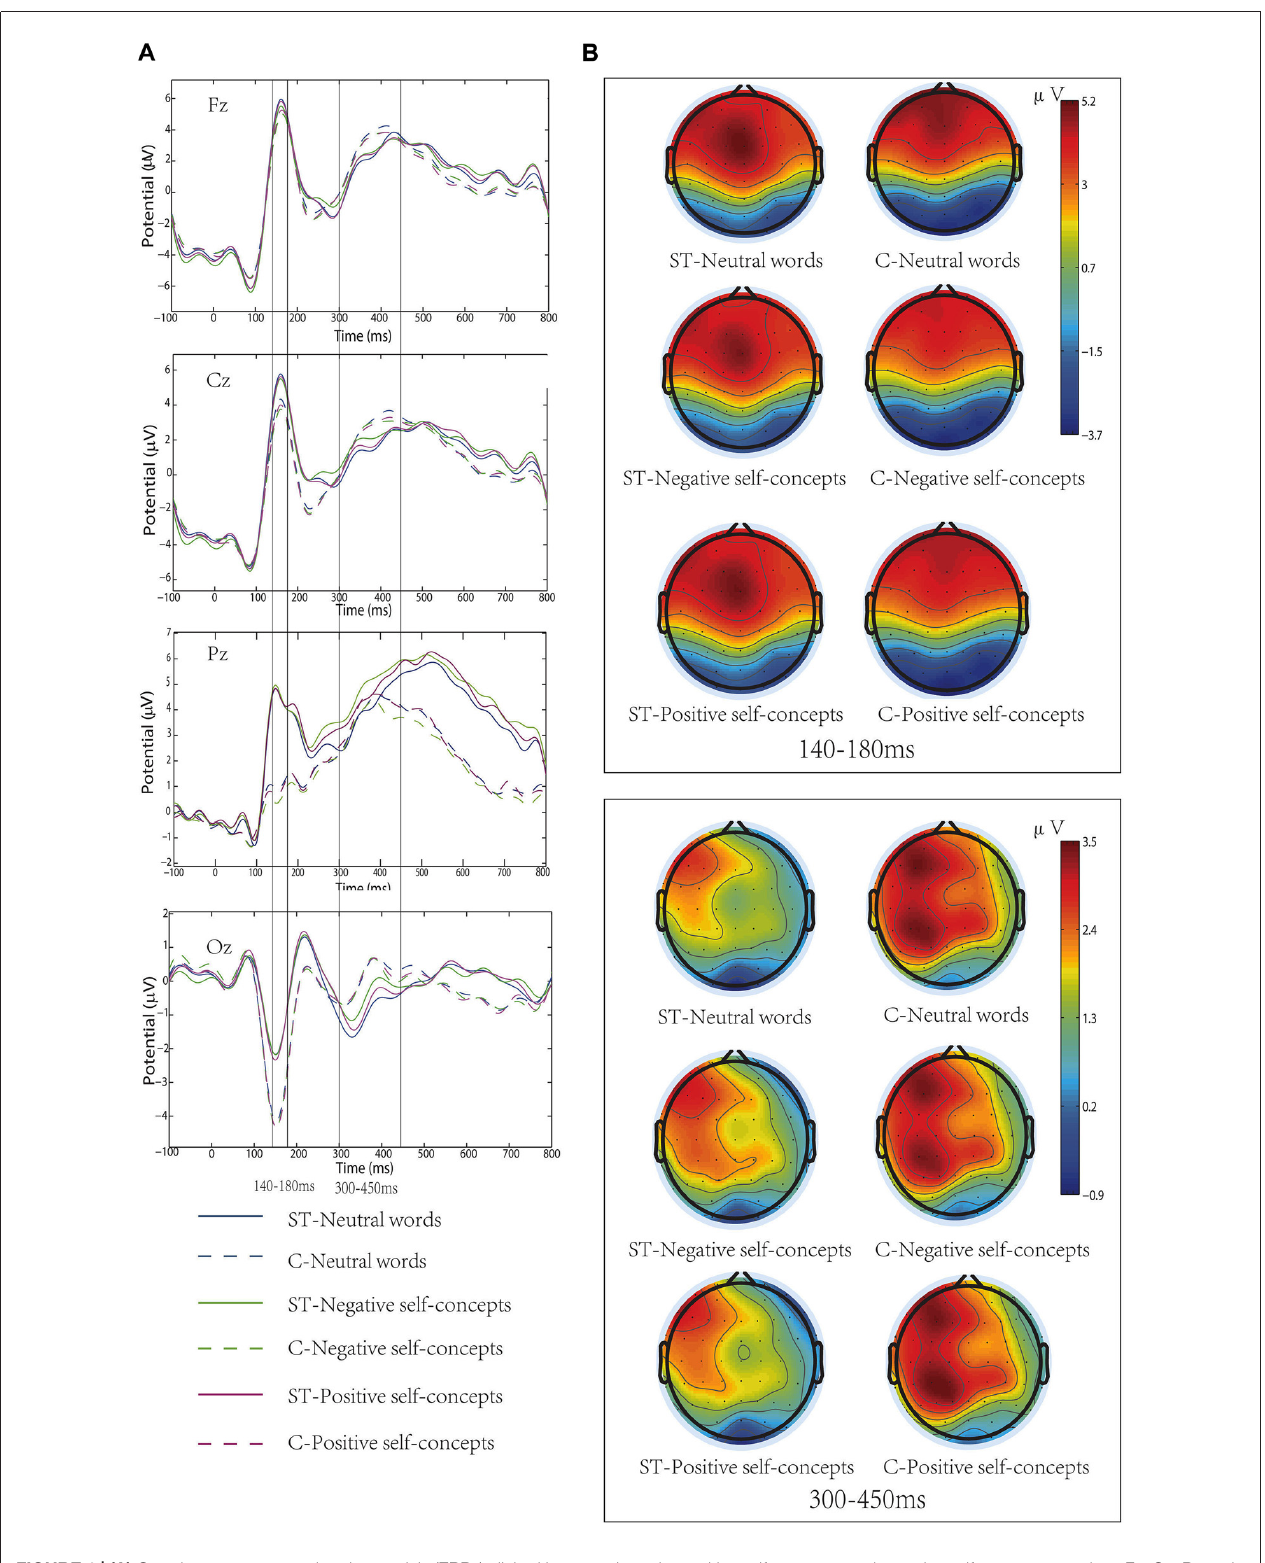
FIGURE 1 | (A) Grand-average event-related potentials (ERPs) elicited by neutral words, positive self-concepts and negative self-concepts words at Fz, Cz, Pz and Oz areas in aging stereotype threat (ST) and control groups (C). (B) Topographical maps for P150/N170 (140–180 ms) and P300 (300–450 ms).